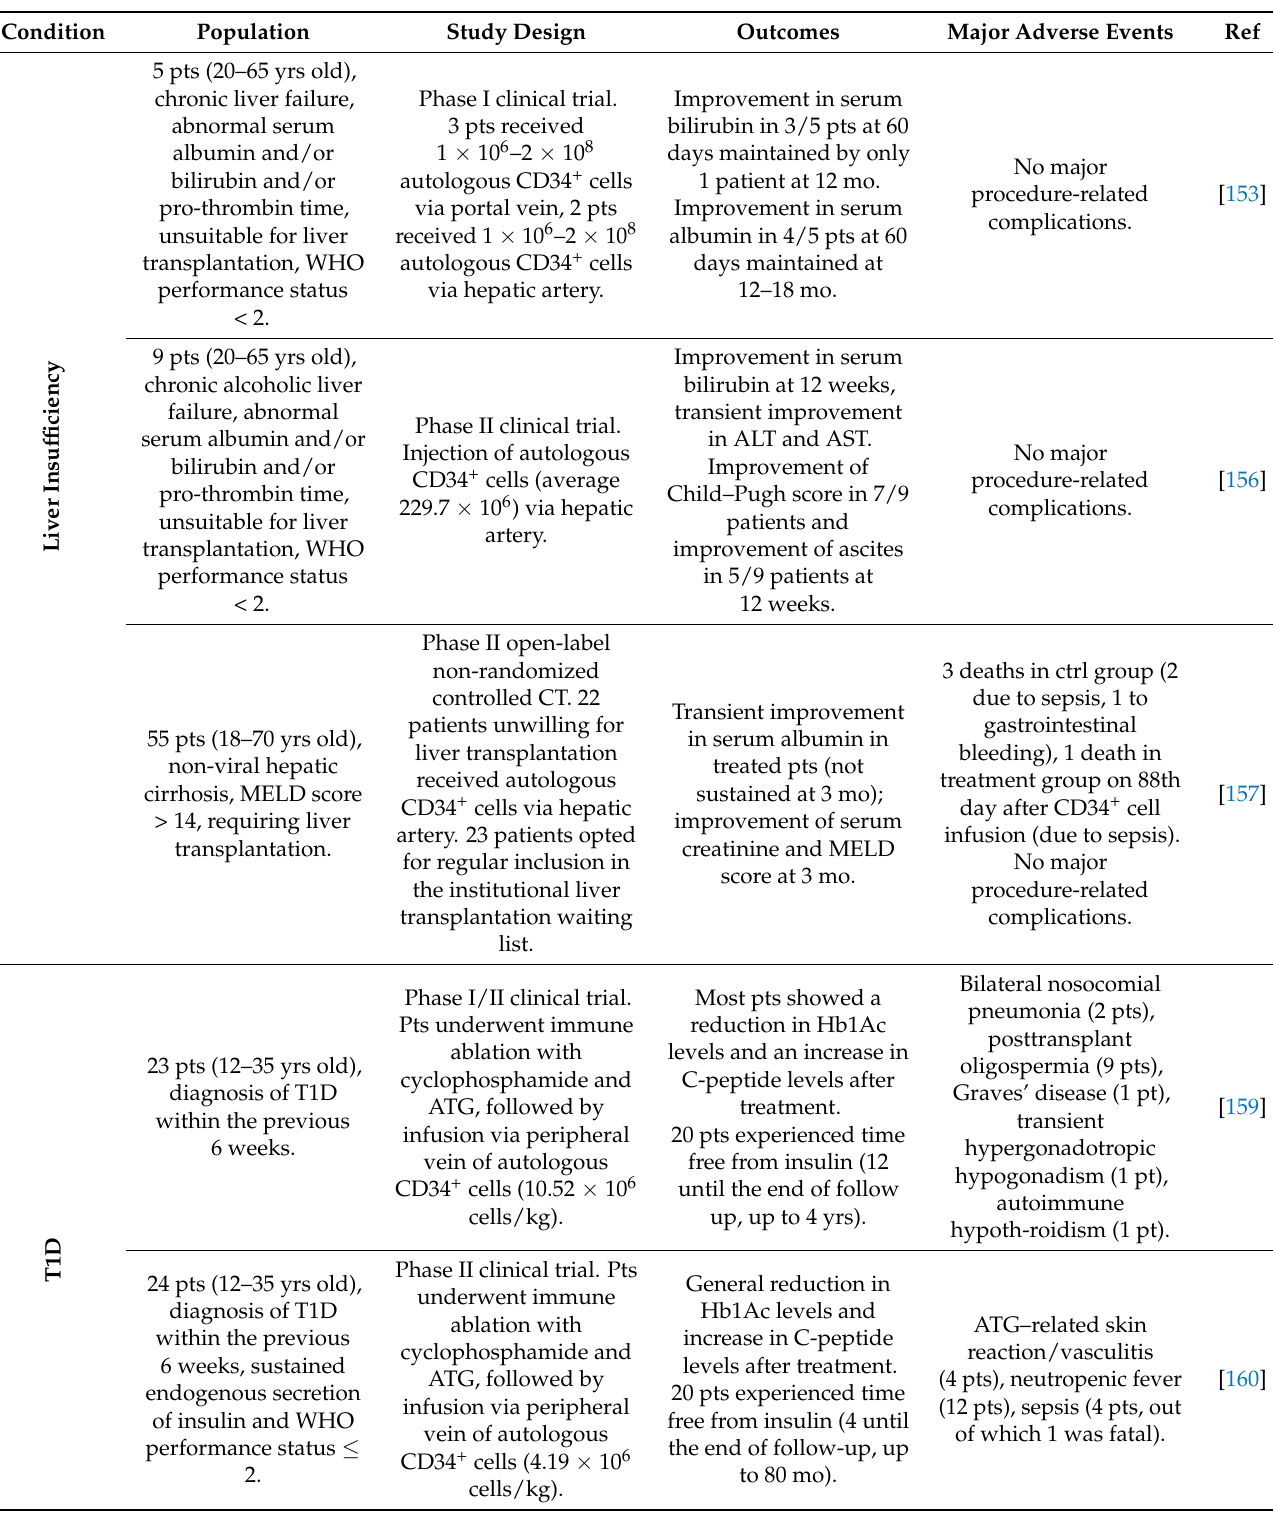
Table 3. Clinical trials on liver insufficiency and